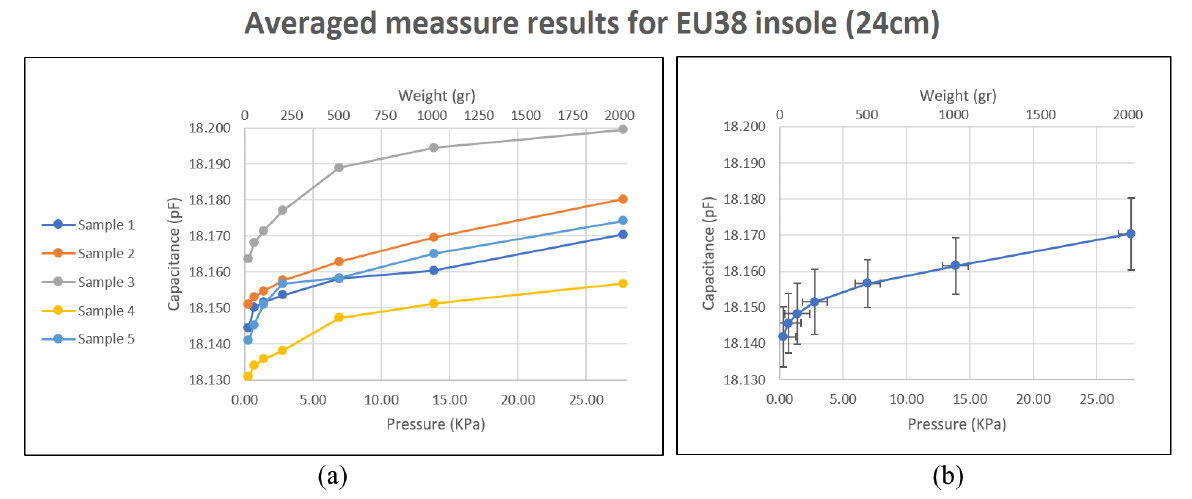
Figure 5. Capacitive plantar insole, size 38 (24 cm). Behavior of sensors against weight in the area they occupy. ( a ) show the average results for each repetition performed. ( b ) shows the combined average of all repetitions.